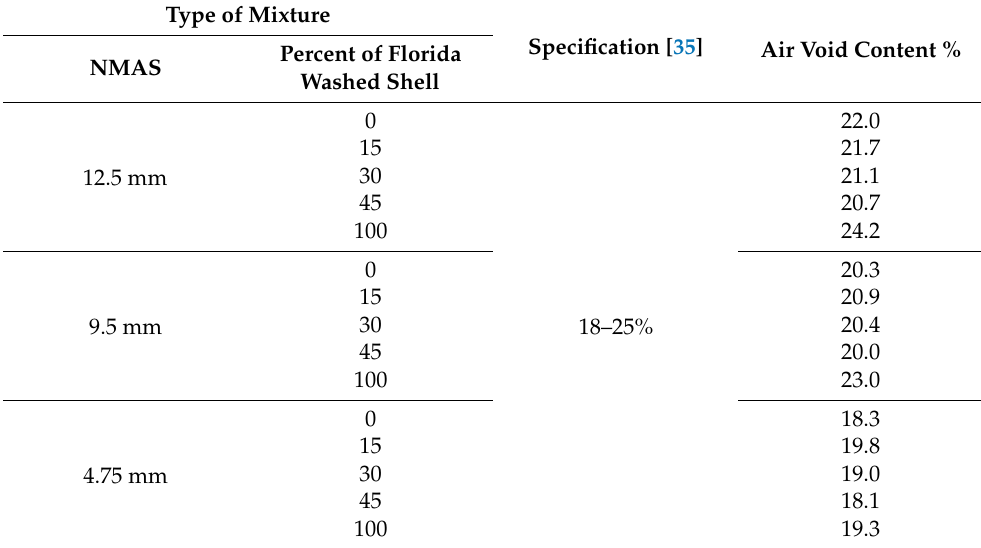
Table 3. Air void content of open-graded asphalt mixtures.